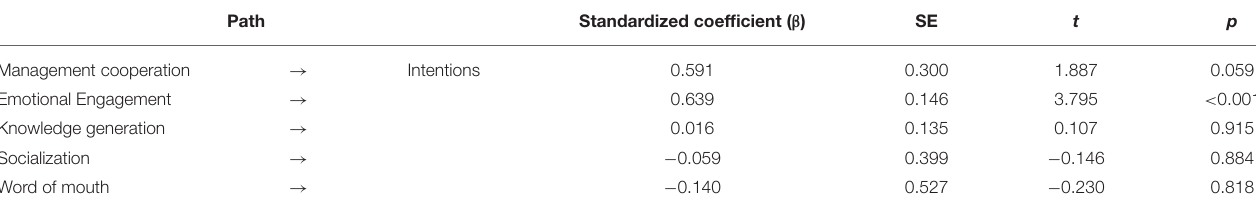
TABLE 5 | Structural equation model (SEM) results.